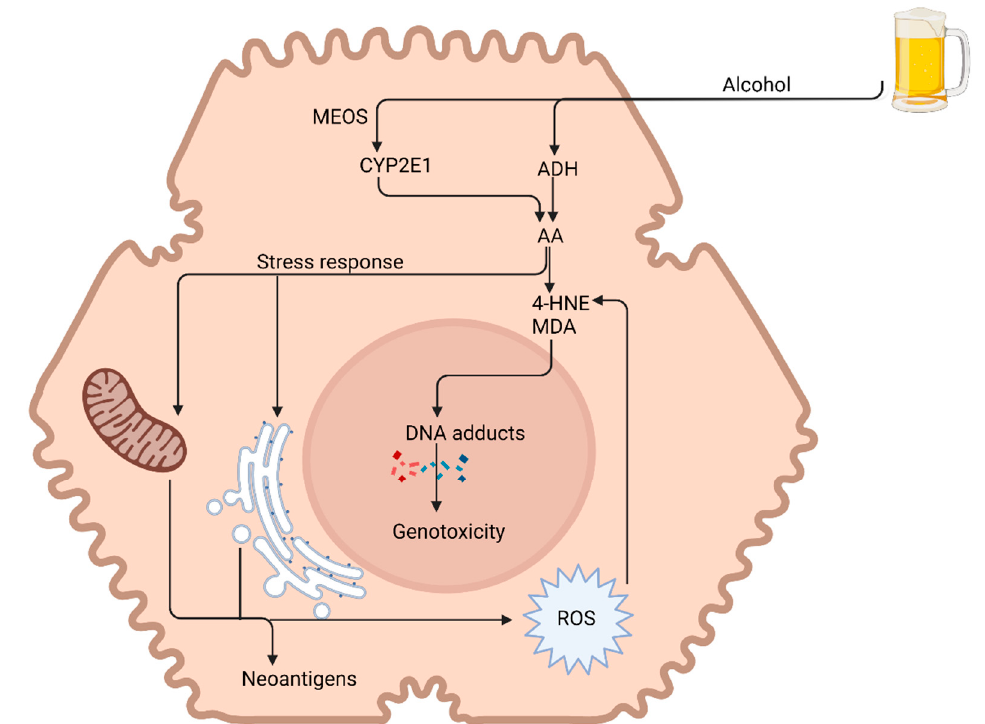
Figure 2. Alcohol-induced liver injury. Acetaldehyde (AA) is responsible for the majority of the toxic effects of alcohol on the liver. Acetaldehyde is extremely lipophilic, leading to the formation of acetaldehyde adducts—malondialdehyde (MDA) and 4-hydroxynonenal (4-HNE). This along with reactive oxygen species (ROS) leads to DNA damage and genotoxicity. Acetaldehyde also induces functional and structural alterations in various cell organelles (e.g., mitochondria and endoplasmic reticulum). MEOS: mitochondrial enzyme oxidation system; ADH: alcohol dehydrogenase. Image created at biorender.com (accessed on 20 August